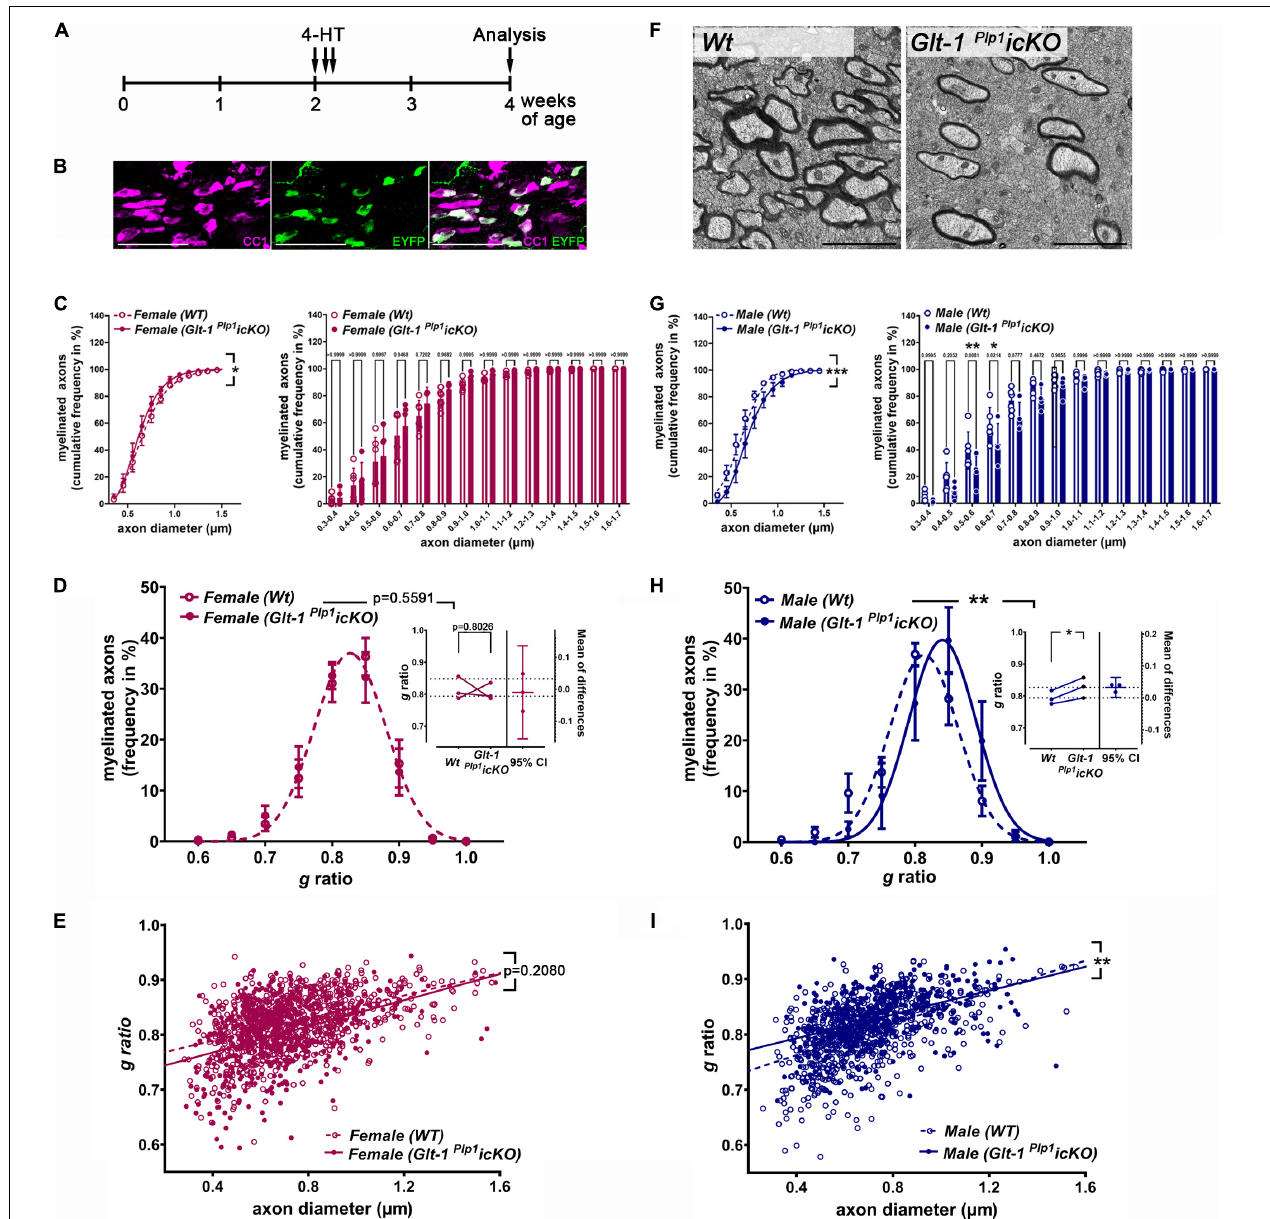
FIGURE 1 | Conditional deletion of Glt-1 from maturing OLGs attenuates CNS myelination in the corpus callosum of male mice. (A) Scheme depicting the timing of intraperitoneal injections of 4-hydroxytamoxifen (4-HT; P14,16,17) in Glt-1 Plp 1 icKO and Wt ( Plp1 CreERT -negative littermate) mice and the developmental time-point of analysis (4 weeks of age). (B) Representative confocal image of the corpus callosum (midline); CC1 marks maturing OLGs (Fuss et al., 2000; Bin et al., 2016) and EYFP, derived from the ROSA reporter, marks cells in which Cre-mediated recombination has occurred successfully (Srinivas et al., 2001). Sale Bar: 50 µ m. (C,G) Line (left) and bar (right) graphs depicting the cumulative frequency distribution of myelinated fibers in the corpus callosum of Wt (open circles) and Glt-1 Plp 1 icKO (filled circles) female (C) and male (G) mice based on axon diameter; for the line graphs, the Gompertz growth curve was used as non-linear regression model (least squares regression) and extra sum-of-squares F -test was used to determine significant differences between regression curves; for the bar graphs, two-way ANOVA and Šidák multiple-comparisons test were used [ p = 0.0307 (female) and p < 0.0001 (male) for overall difference between genotypes]. (D,H) Line graphs depicting the frequency distribution of myelinated fibers in the corpus callosum of Wt (open circles) and Glt-1 Plp 1 icKO (filled circles) female (D) and male (H) mice based on g -ratio. Gaussian distribution was used as non-linear regression model (least squares regression); extra sum-of-squares F -test was used to determine significant differences between regression curves. The insets depict mean g- ratios per animal pairs of individual litters; paired t- test (between individual animals from the same litter; data are shown for 3 litter pairs) was used to determine significance. (E,I) Scatter plots depicting g-ratios vs. axon diameter for the corpus callosum of Wt (open circles) and Glt-1 Plp 1 icKO (filled circles) female (E) and male (I) mice. The lines represent linear regression fits to pooled data from all animals for each genotype; an F -test was used to determine significant differences between the slopes of the regression curves. (F) Representative electron microscopic images of the corpus callosum of Glt-1 Plp 1 icKO and Wt ( Plp1 CreERT -negative littermate) male mice injected with 4-HT. Scale bar: 2 µ m. female Glt-1 Plp 1 icKO ( n = 5), female Wt ( n = 6), male Glt-1 Plp 1 icKO ( n = 4), male Wt ( n = 6). * p ≤ 0.05, ** p ≤ 0.01, *** p ≤ 0.001.